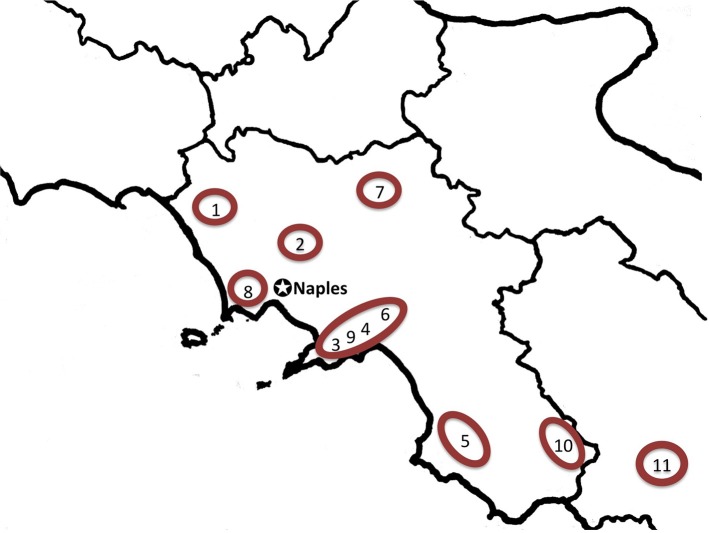
Map of Campania and adjacent regions indicating considered field studies addressing popular medicinal plant use. 1, Roccamonfina, Caserta (Antonone et al., 1988); 2, Caserta, Caserta (De Feo et al., 1991); 3, Peninsula Sorrentina, Napoli/Salerno (De Feo et al., 1992); 4, Coast of Amalfi, Salerno (De Feo and Senatore, 1993); 5, Monte Vesole and Ascea, Salerno (Scherrer et al., 2005); 6, Montecorvino Rovella, Salerno (De Natale and Pollio, 2007); 7, Sannio area, Benevento (Guarino et al., 2008); 8, Phlegraean Fields Regional Park (Motti et al., 2009); 9, Amalfi Coast (Savo et al., 2011); 10, National Park of Cilento and Vallo di Diano (Di Novella et al., 2013); 11, Rotonda, Pollino National Park (Di Sanzo et al., 2013).